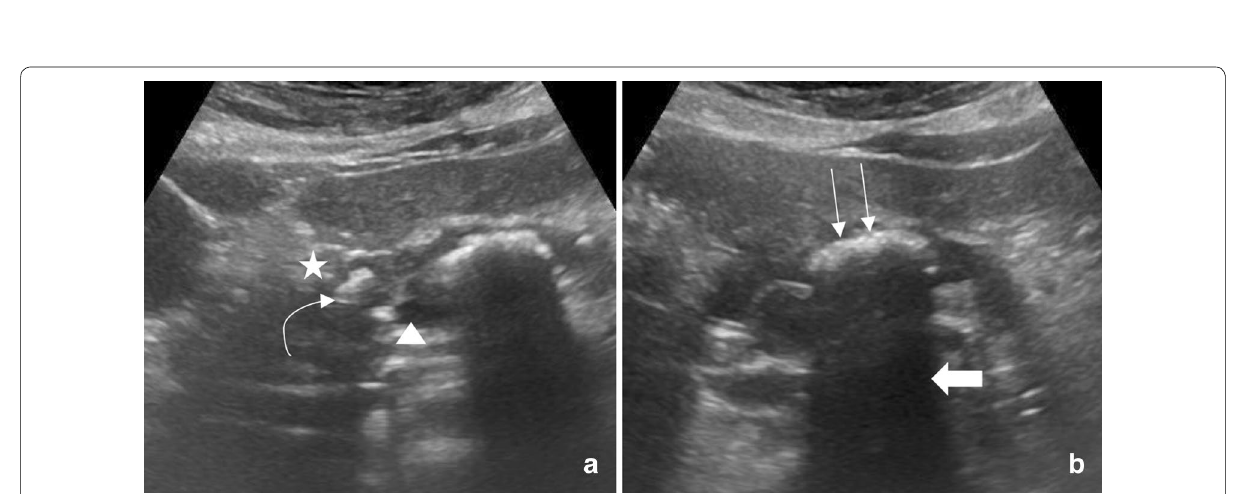
Fig. 6 Calcific pancreatitis: a Heterogenous pancreatic tissue (star) with parenchymal calcifications (curved arrow) and cystic areas (arrowhead) seen in the pancreas. b Dense posterior acoustic shadowing (thick arrows) from intraductal calculus (long thin arrows) is also